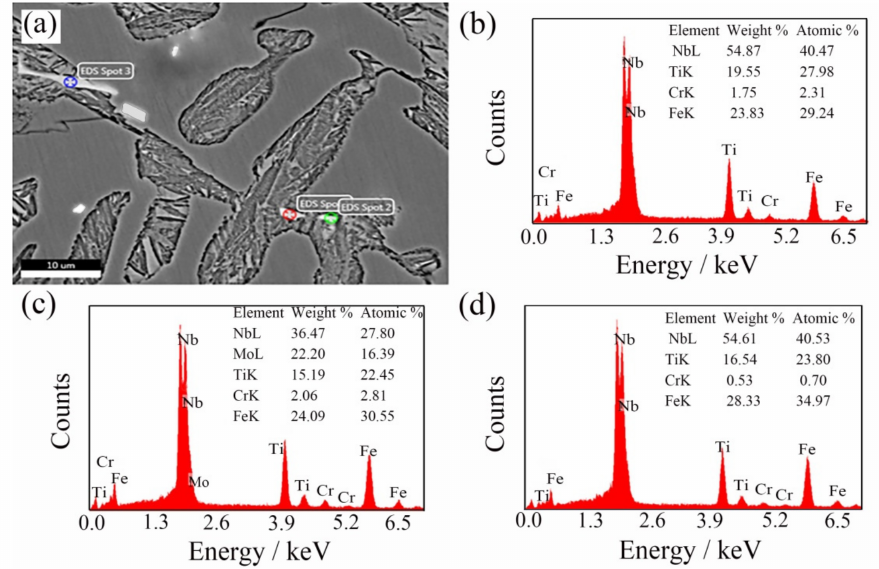
Figure 4. BSE observation after adding 0.30 wt % (NbTi)C particles ( a ) and the EDS of spot 1 ( b ), spot 2 ( c ), and spot 3 ( d ), respectively.